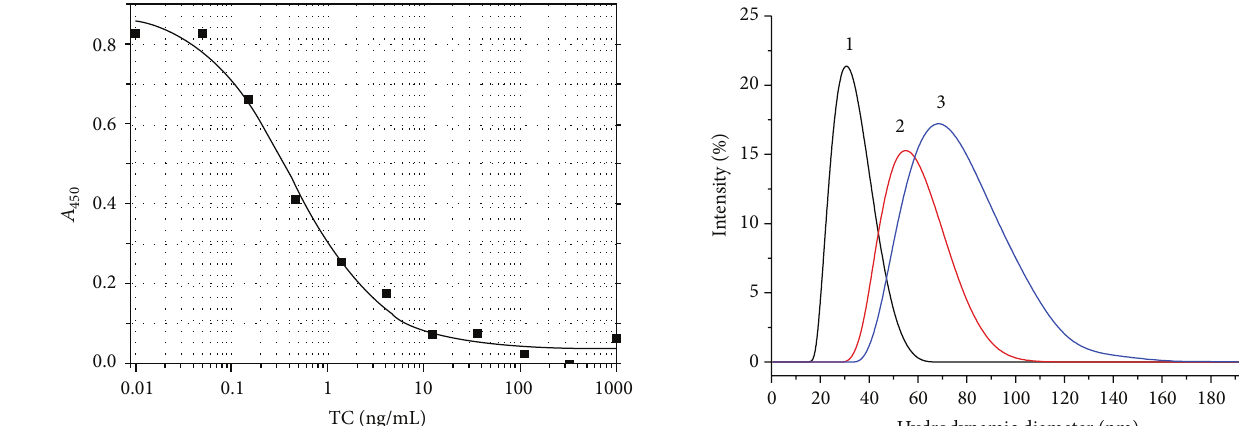
Figure 5: Hydrodynamic diameters for GNPs ( 1 ) and their con- jugates with anti-TC antibodies, showing an antibody :GNP molar ratio of 23.5 :1 ( 2 ) and 47: 1 ( 3